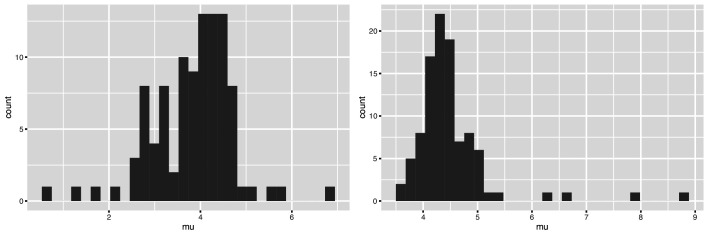
Bootstrap values of the mean serial interval for (left) Singapore and (right) Tianjin, based on 100 replicates using the first four cases in each cluster.